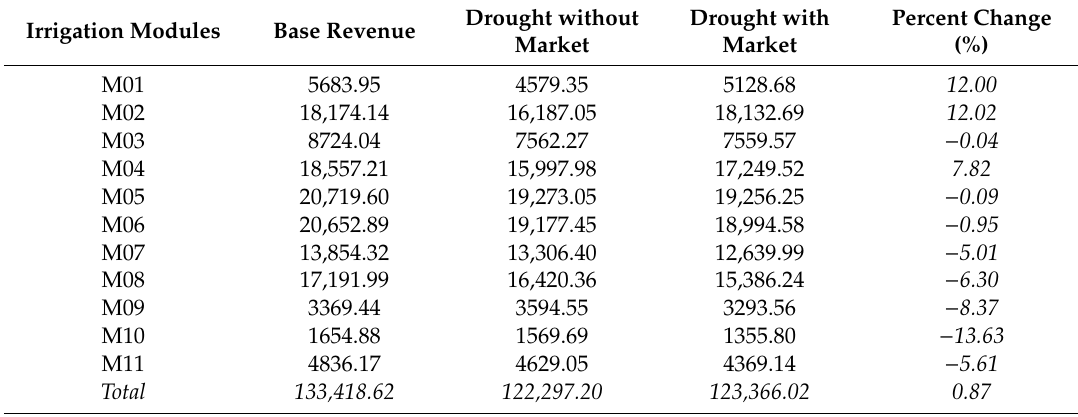
Table 6. Module net revenues with and without 25% shortage and water market (in